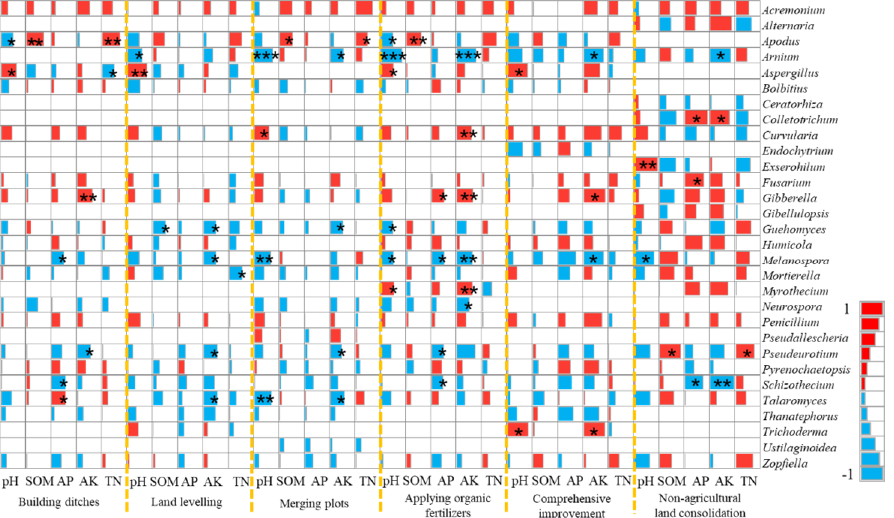
Figure 10. Correlation between soil chemical properties and fungal community structure in dif- ferent groups. (Note: In the figure, warm colors indicate positive correlation, and cool colors indicate negative correlation. *, **, *** indicate significant correlation at the levels of 0.05, 0.01, and 0.001,